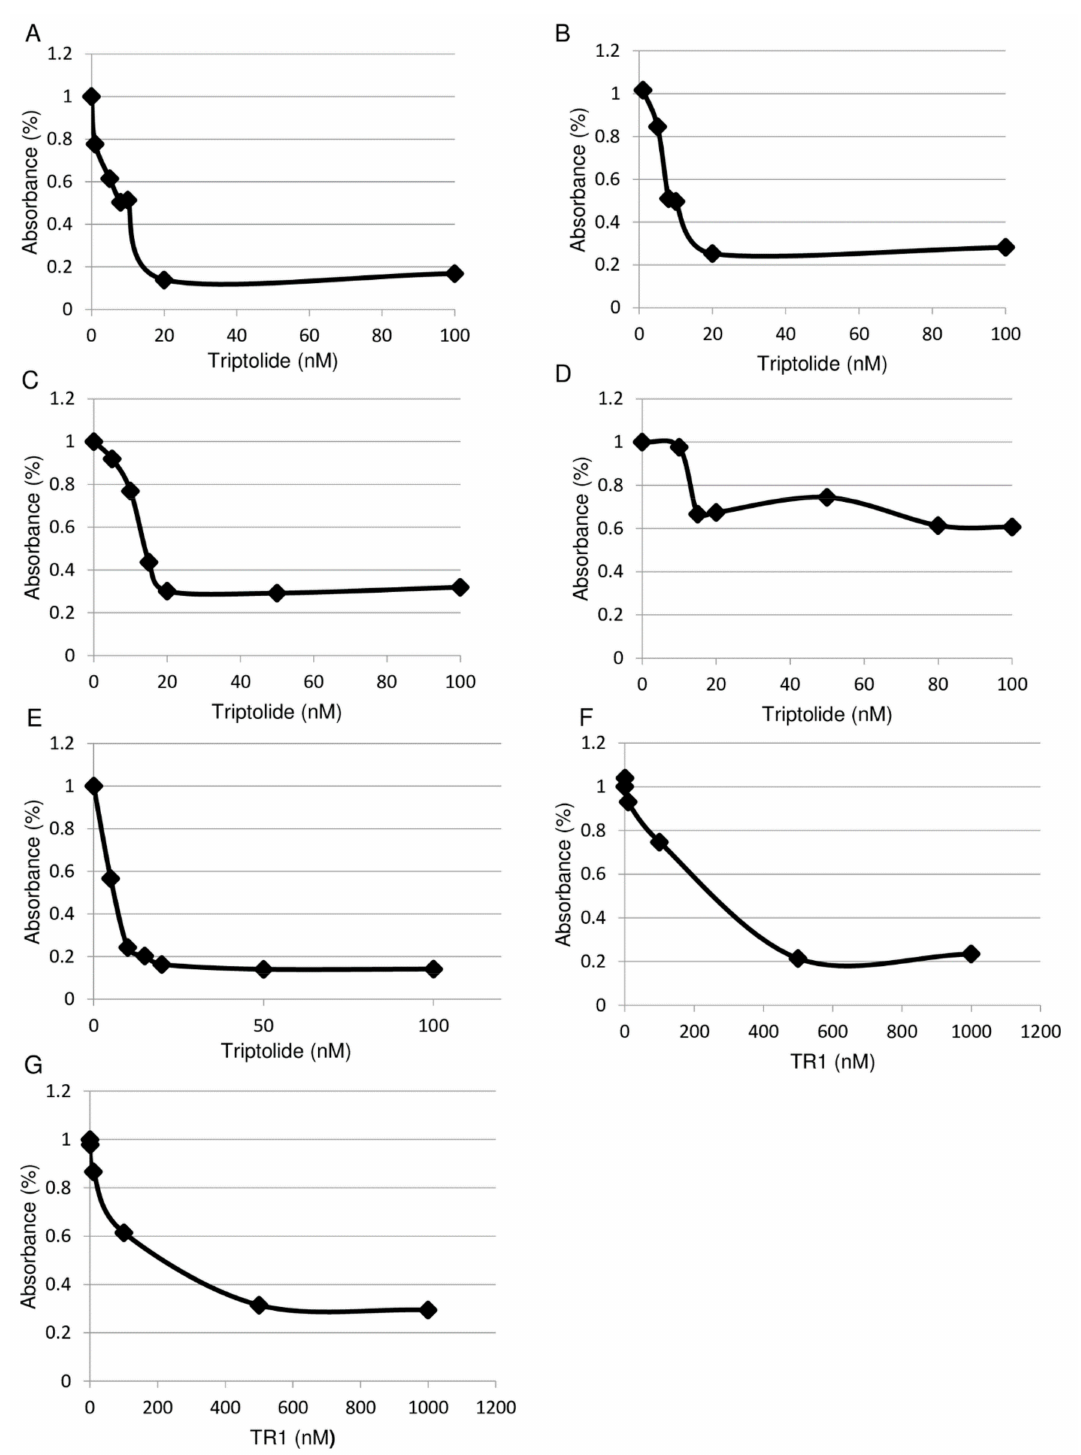
Figure 2. In vitro cytotoxic e ff ect of Triptolide and TR1against MM cells and leukemia cells. Horizontal axis shows the concentration of the compounds in nM. Vertical axis shows the percent of control of the absorbance value in the WST-1 assay. The representative results of at least three independent experiments are shown. ( A ) Triptolide against MSTO wt; ( B ) triptolide against MSTO clone12; ( C ) triptolide against JMN; ( D ) triptolide against Jurkat ( − ); ( E ) triptolide against Jurkat CD26( + ); ( F ) TR-1 against MSTO wt; ( G ) TR-1 against MSTO